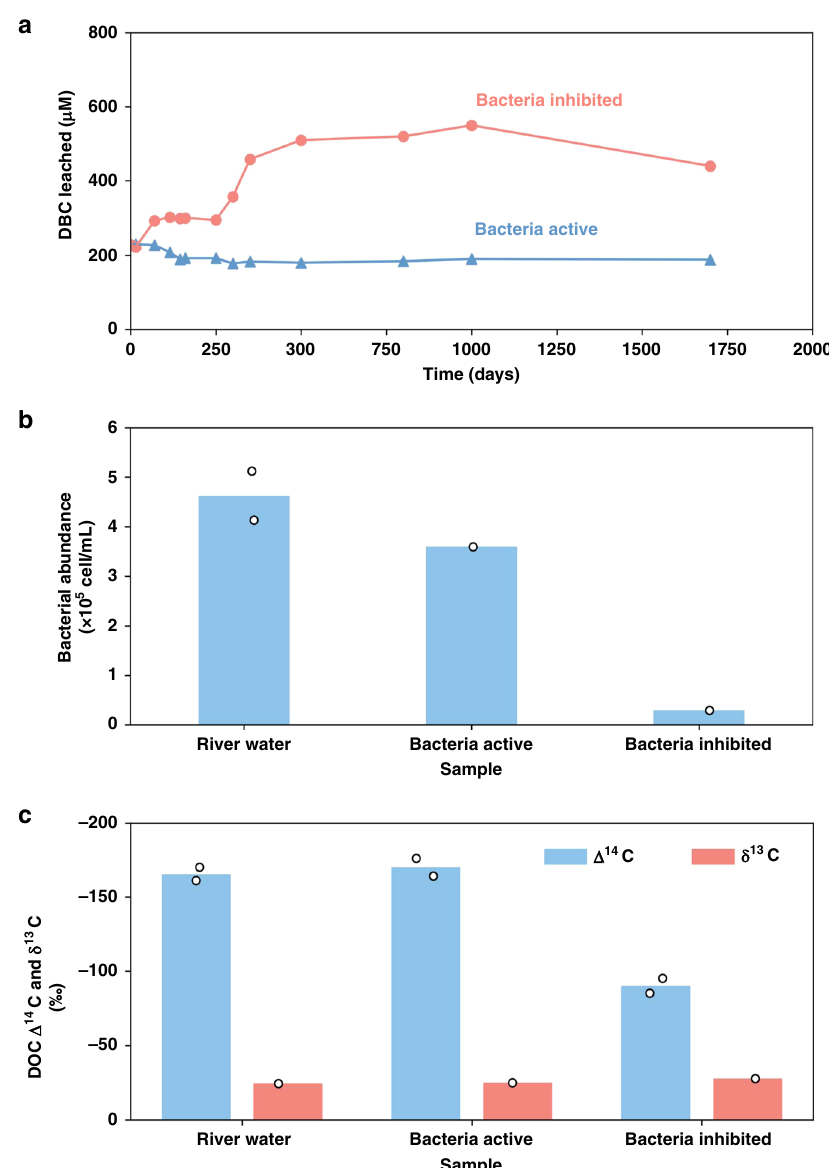
Fig. 2 Characteristics of DBC in the leaching experiments. a Long-term time incubation showing the leaching of DBC (dissolved black carbon), measured as DOC (dissolved organic carbon) concentrations from charcoal in both bacteria-active and bacteria-inhibited river waters during the 1700-day incubation period; b bacterial abundance, and c Δ 14 C and δ 13 C values of DOC measured in the river water and bacteria-active and bacteria-inhibited river waters at the end of the experiments. The bar charts are the average values of the duplicate measurements (true value for single point measurement). The black circles are corresponding data